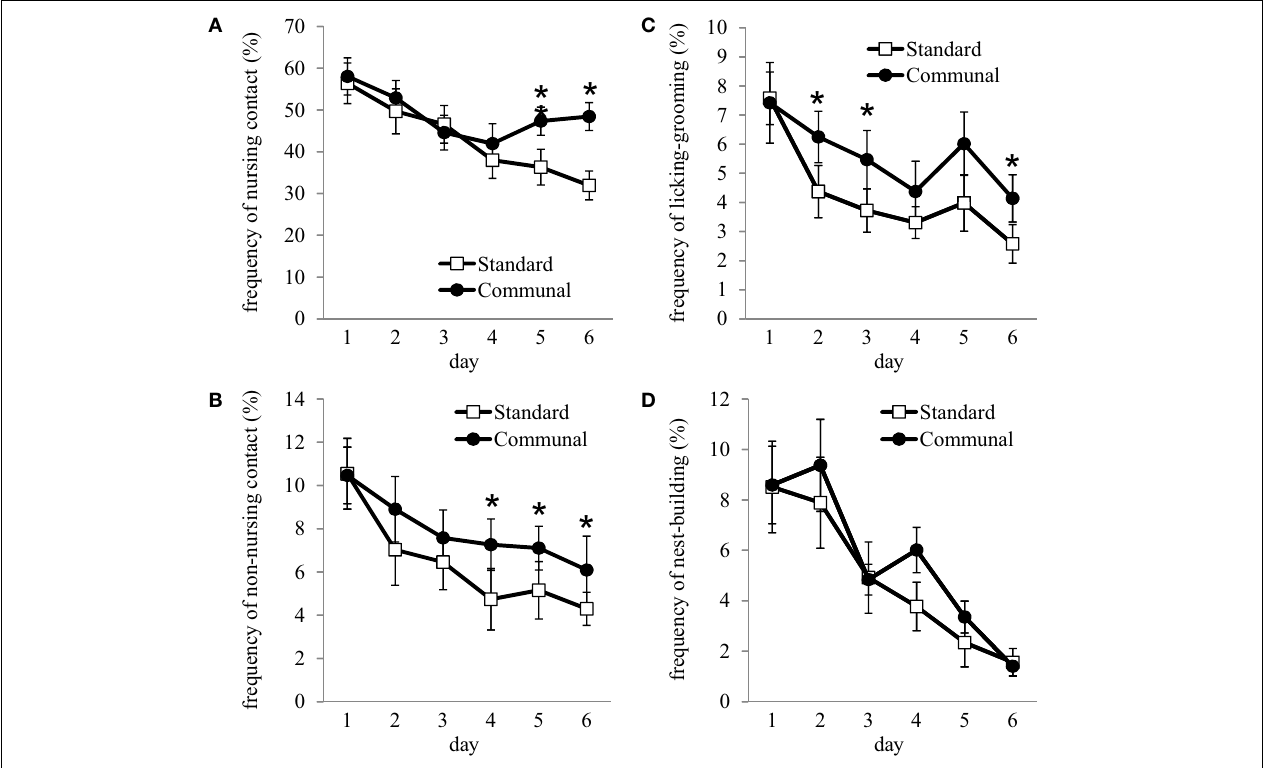
FIGURE 3 | Postpartum maternal behavior amongst F1 standard and communally reared females. Frequency of (A) nursing-contact, (B) non-nursing contact, and (C) licking/grooming was signifi cantly elevated amongst communal females. (D) Nest-building did not differ amongst standard compared to communally reared females. * p < 0.05.